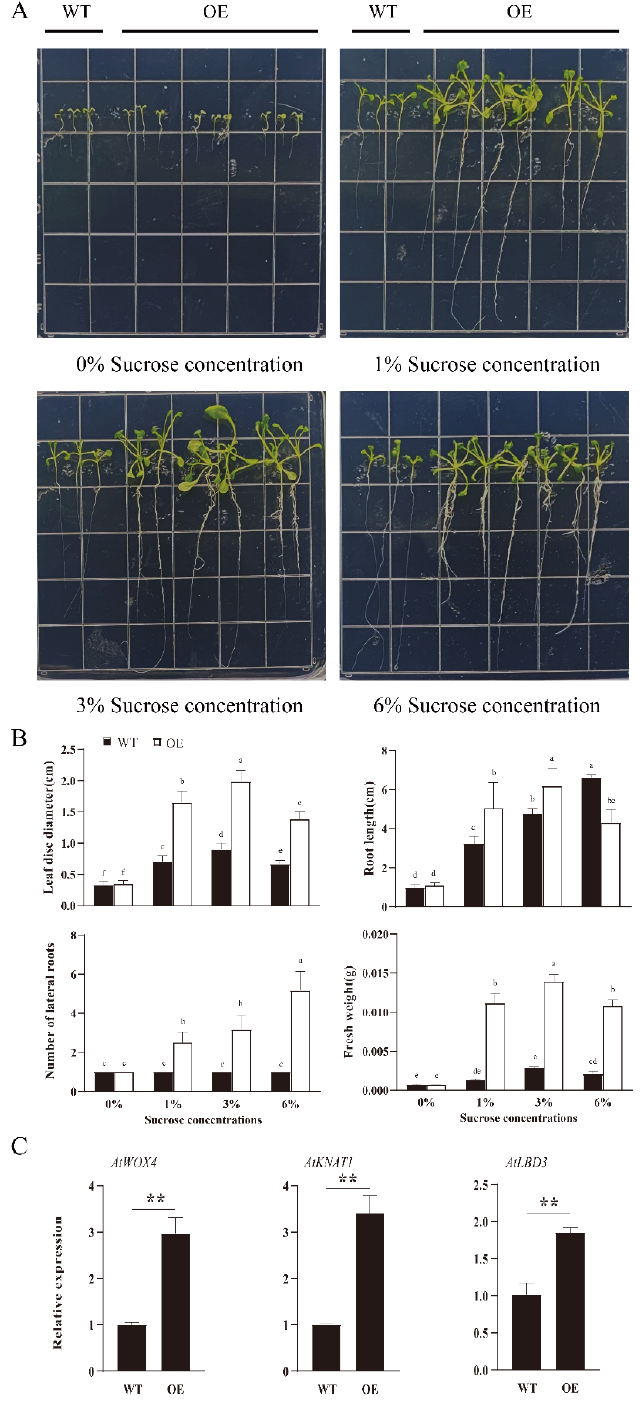
Figure 5. RsSUC1b ‐ overexpressing (OE) Arabidopsis plants response to the different sucrose concentrations. The morphology ( A ) and morphological index ( B ) were 20 ‐ day ‐ old wide type (WT) and transgenic line seedlings after exogenous sucrose treatment. ( C ) The expression profiles of plant development-related genes of AtWOX4 , AtKNAT1 , and AtLBD3 in WT and transgenic plants under sucrose treatments of 6%. Each bar shows the mean ± SD (n = 3). Values with different letters indicate a significant difference at p < 0.05 according to Duncan’s multiple range tests. * indicates significant difference at p < 0.05, and ** indicates significant difference at p < 0.01 according to Student’s t